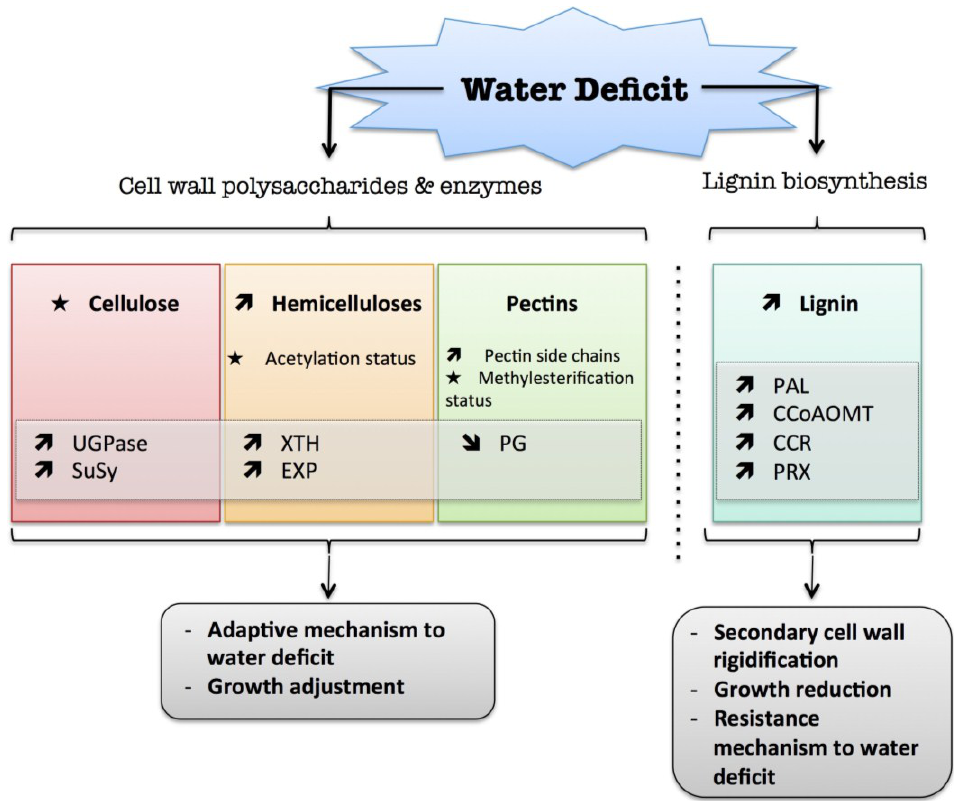
Figure 1. Diagram summarizing the plant cell wall response to water deficit. The schematic presentation is deduced from the results of different studies reported in the review. Arrow (  ) means increased abundance and arrow (  ) means decreased abundance of the molecules. Star (  ) means contrasting data on the gene/protein or the molecule studied according to the literature cited in the review. Cell wall (CW); xyloglucan endo-β-transglucosylases/hydrolases (XET/XTH); expansin (EXP); sucrose synthase (SuSy); UDP-glucose pyrophosphorylase (UGPase); polygalacturonase (PG); pectin